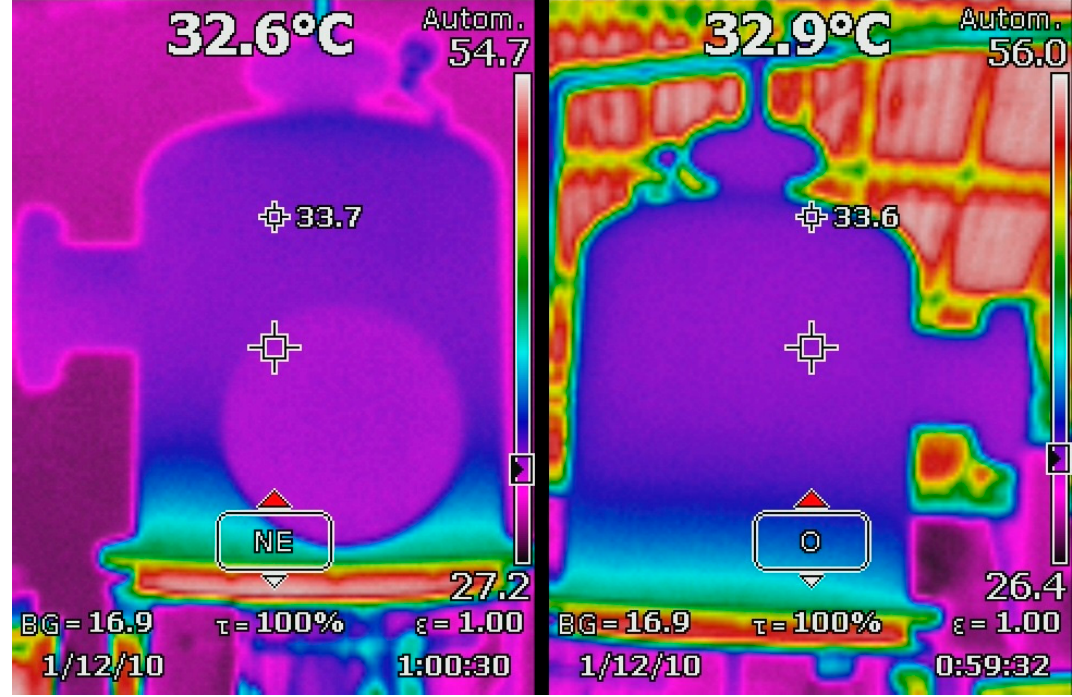
Figure 3. Thermal images of the upper chamber during O 2 + air operation with packed material addition.